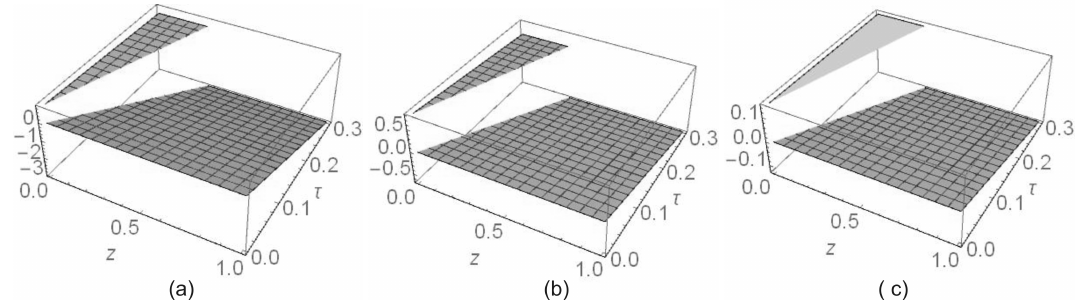
Figure 3. Reduced potential gradient Ψ Z ( z , τ ) ≡ Ψ z / A 4 suffers a jump across the invasion front z = ζ 0 ( τ ) . The contrast parameters are a = 0.33 and b = 0.3,0.6 and 1.2 in ( a – c )